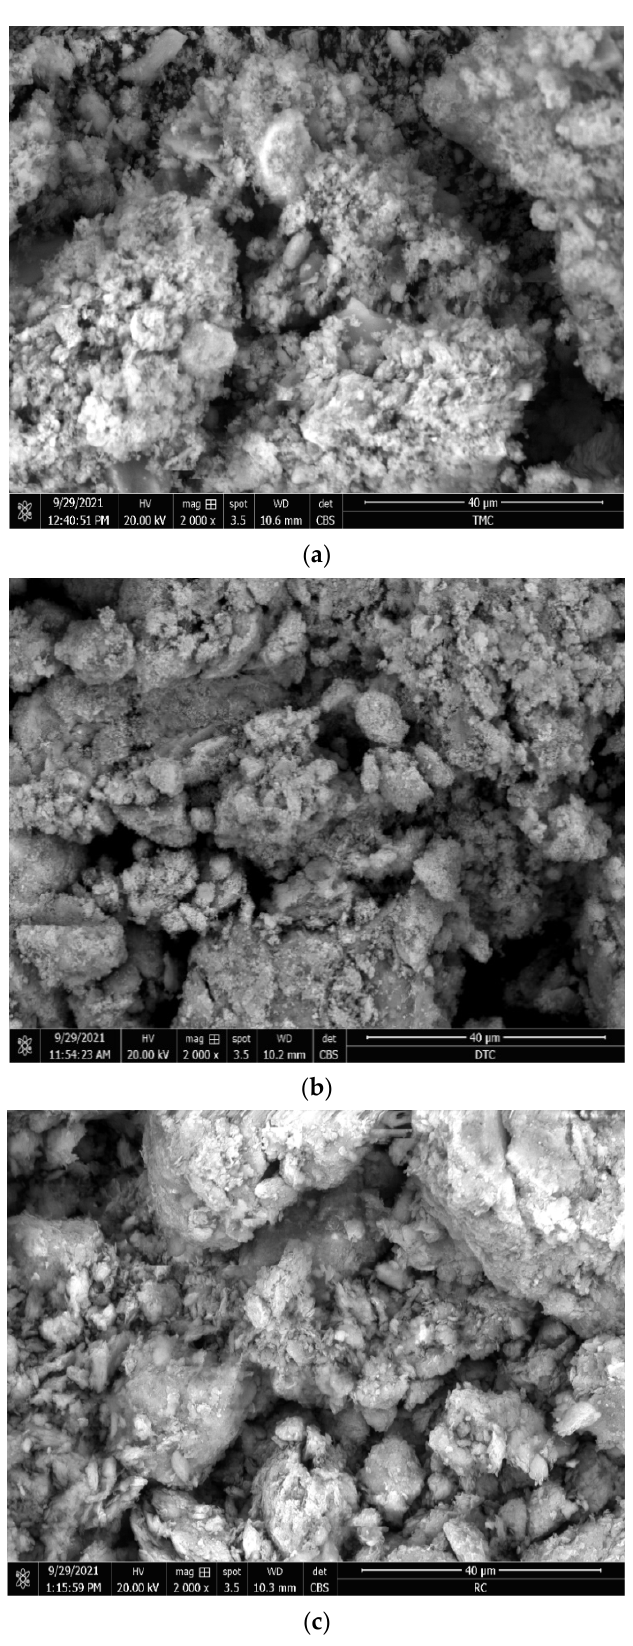
Figure 4. ( a – c ): SEM images of raw clay (MM), doped titanium composite (DTC) and the tripartite magnetic nancomposites (TMC) showing their surface morphologies.